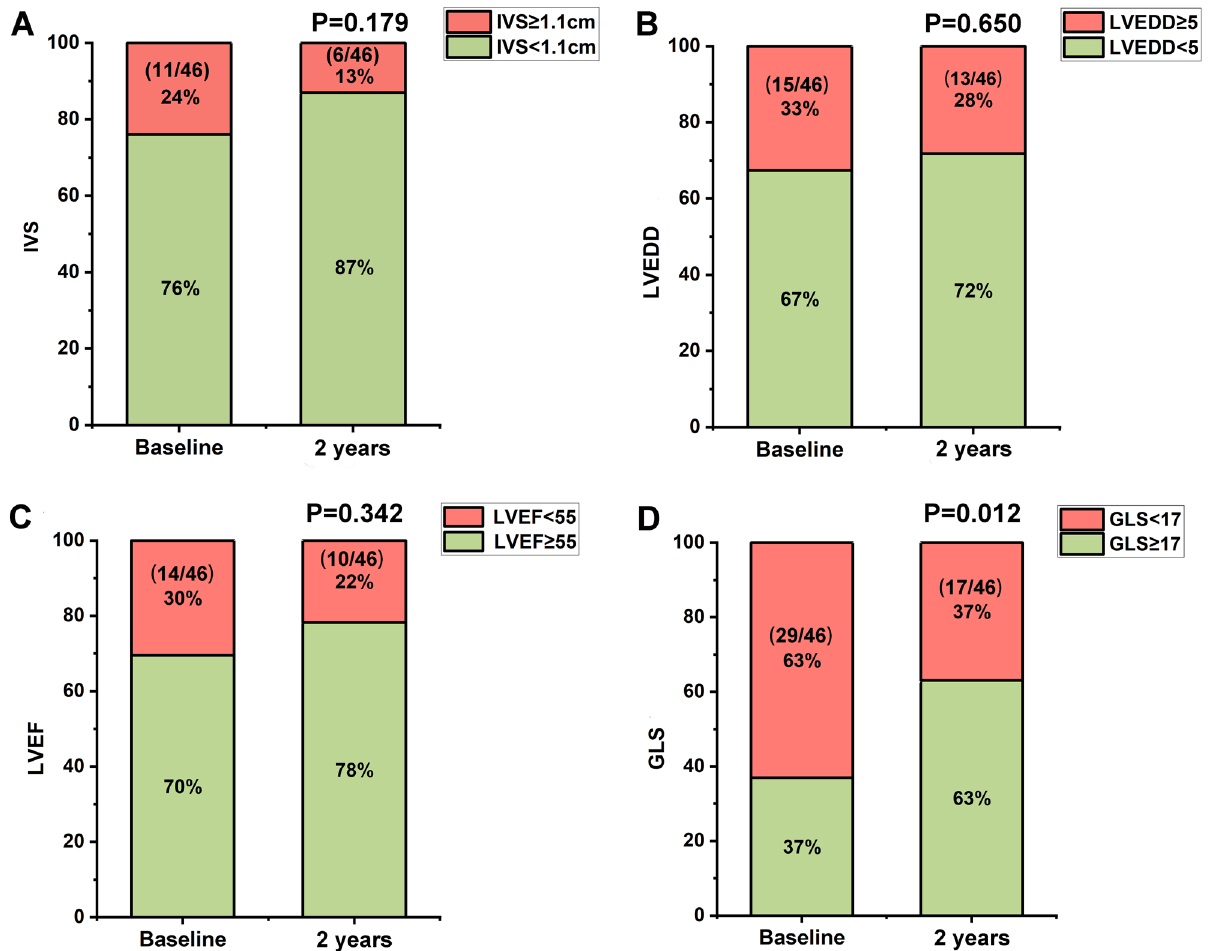
Figure 2. Changes in LV structural and functional parameters during 2-year follow-up in patients with FM. The proportion of FM patients with IVS < 1.1 cm ( A ) and LVEDD < 5 cm ( B ) at 2-year follow-up was higher than discharge. The proportion of patients with LVEF < 55% ( C ) and GLS < 17% ( D ) at 2-year follow-up was lower than discharge (Pearson test was used for comparison). http://m. qpic. cn/ psc?/ V53wp KJ24F 3mOO0 15TIE 1dJF3 728Qw lj/ ruAMs a53pV QWN7F LK88i 5oJoe 1CbnG P7nop AtC78 vvPF7 JLlGW MJHEj gyx. eGw3b T2kPt wNmkH V6l18 AWl4X MK47G uPOF3 JaC6q ON*k4Z5k !/ mnull & bo= gAdAB oAHQA YBByA !& rf= photo